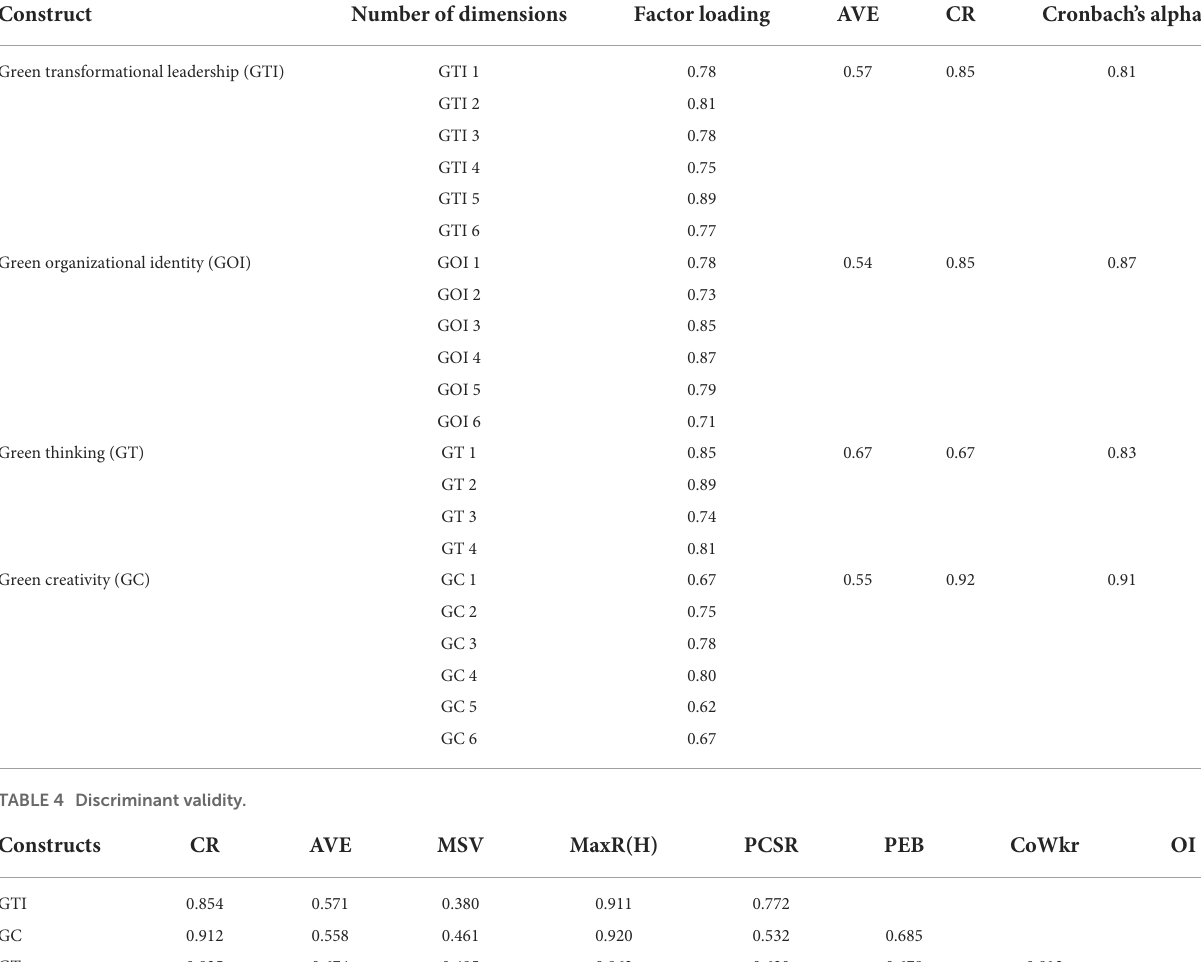
TABLE 3 Construct validity.